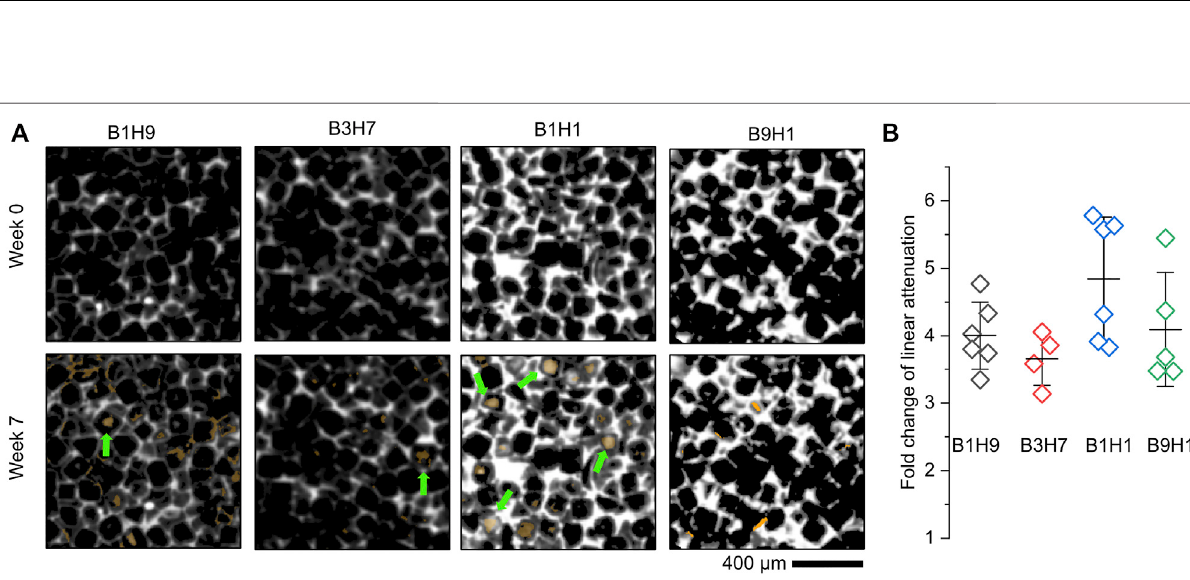
Frontiers in Materials |